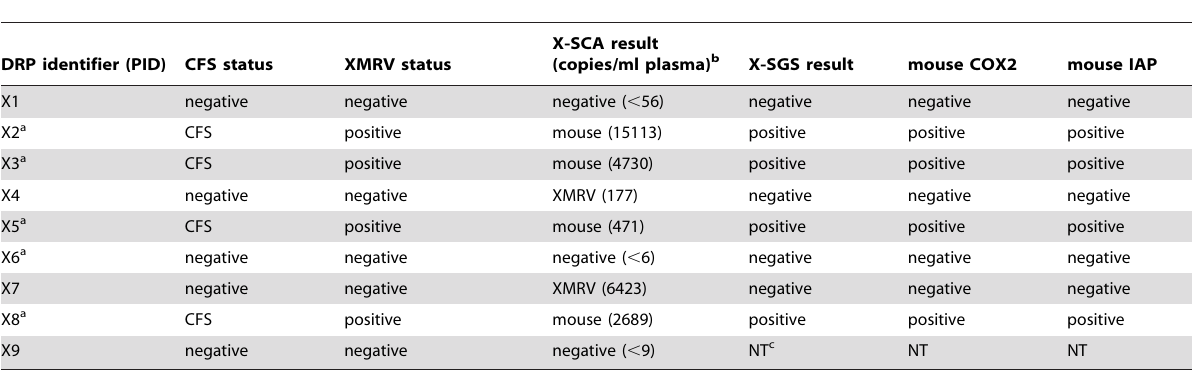
Table 1. Independent evaluation of plasma samples from patients with previously reported XMRV